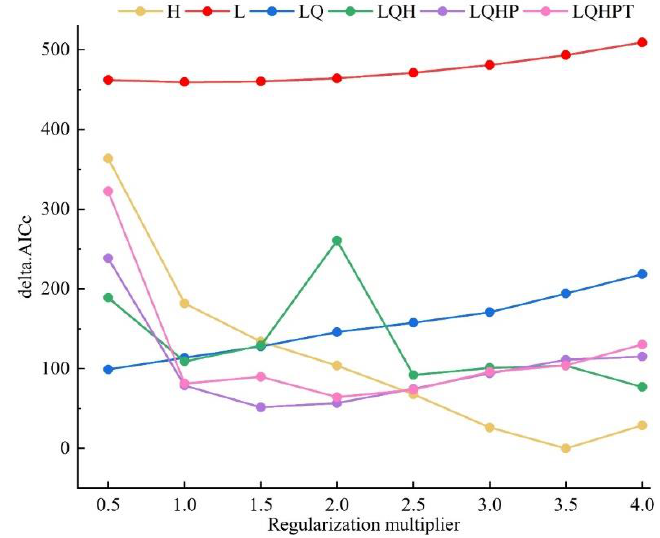
Figure 2. Parameter combination results for Anthonomus grandis by ENMeval package.